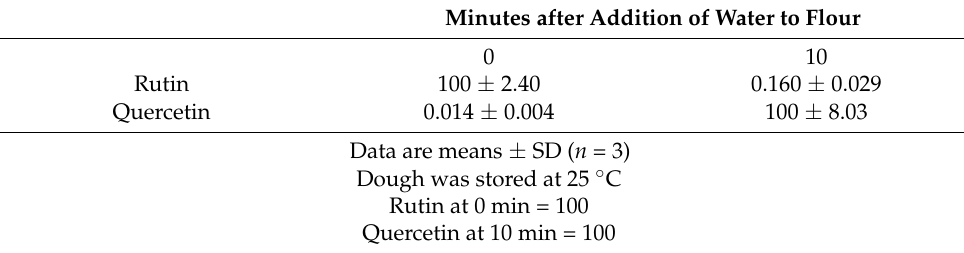
Table 3. Relative rutin and quercetin concentration in FC